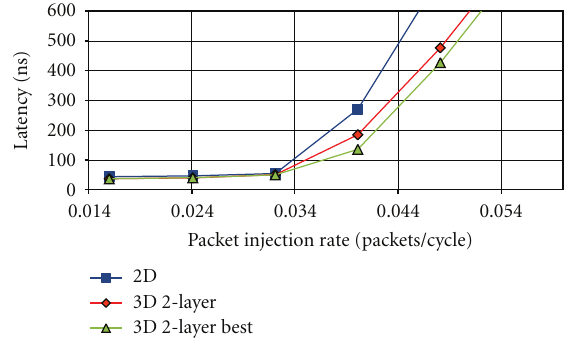
Figure 21: Latency comparison for 2D and 2-layer implementa- tions of ami33 .